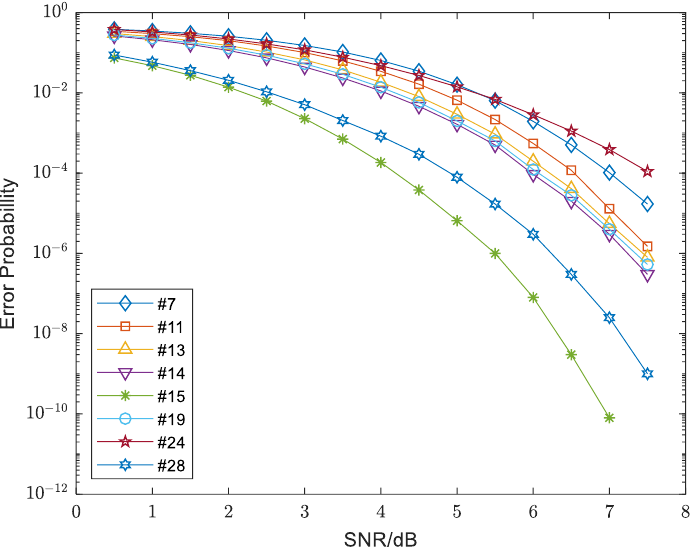
Figure 5. Error probability of sub-channels (7,11,13,14,15,19,24,28) in strong turbulence. Table 6. The value range of β in different code lengths. Range of β When SNR Is Range of β When SNR Is N Less than M-SNR More than M-SNR